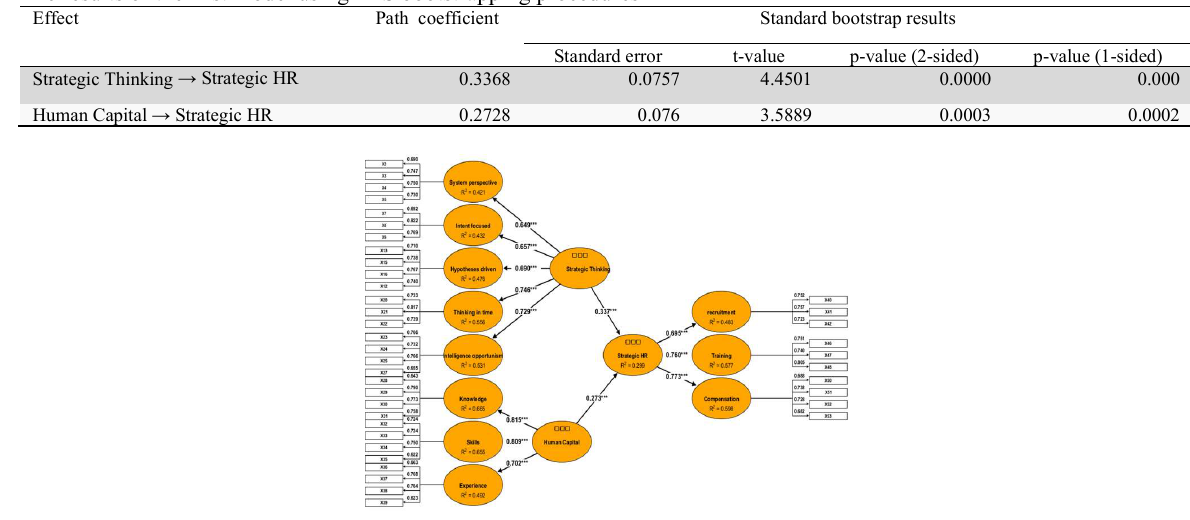
Fig. 3. The results of the first model using PLS bootstrapping